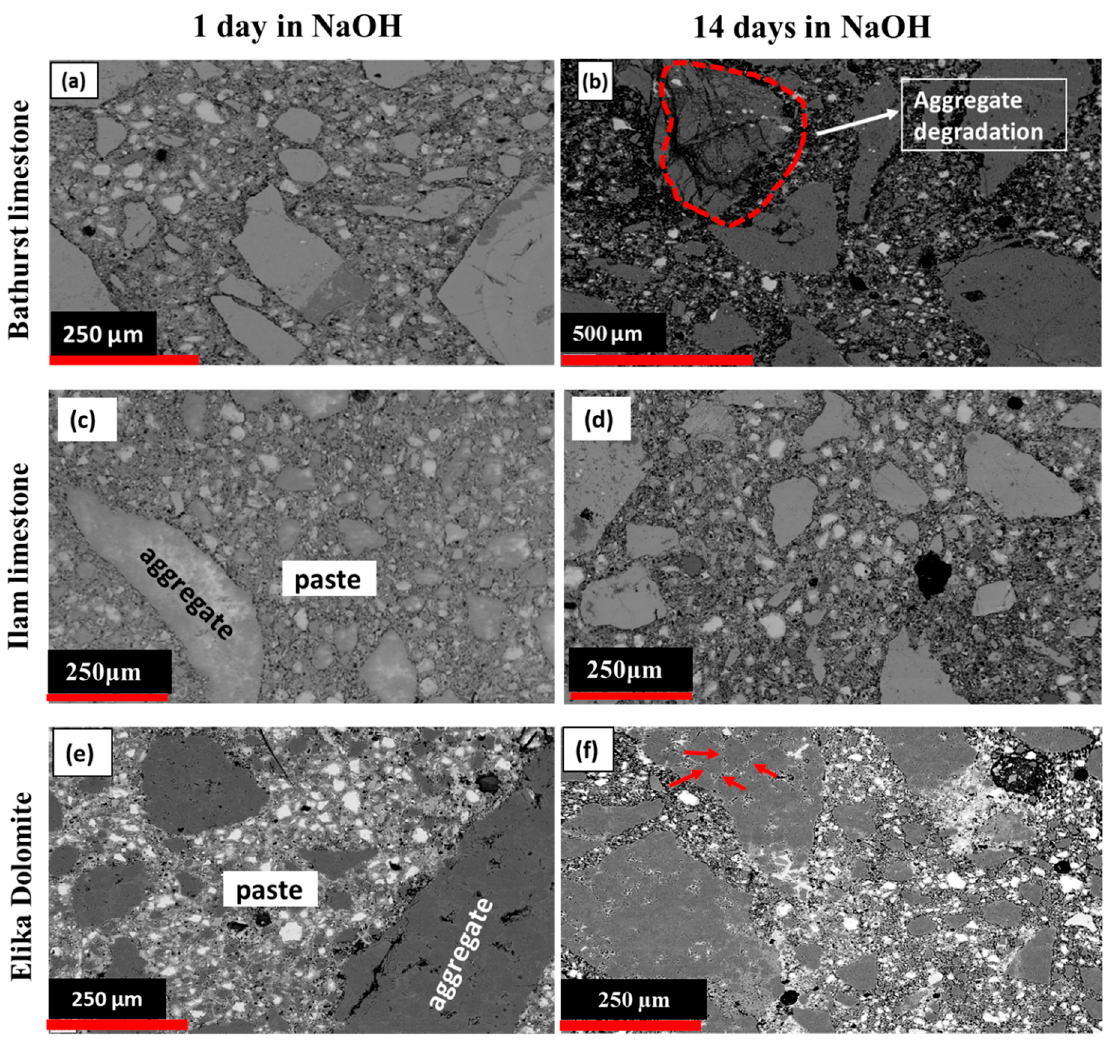
Figure 7. Comparison of SEM micrographs of mortar bars: Bathurst limestone ( a ) (1 day), ( b ) (14 days), Ilam limestone ( c ) (1 day), ( d ) (14 days), dolomite ( e ) (1 day), and ( f ) (14 days) immersed in NaOH solution.